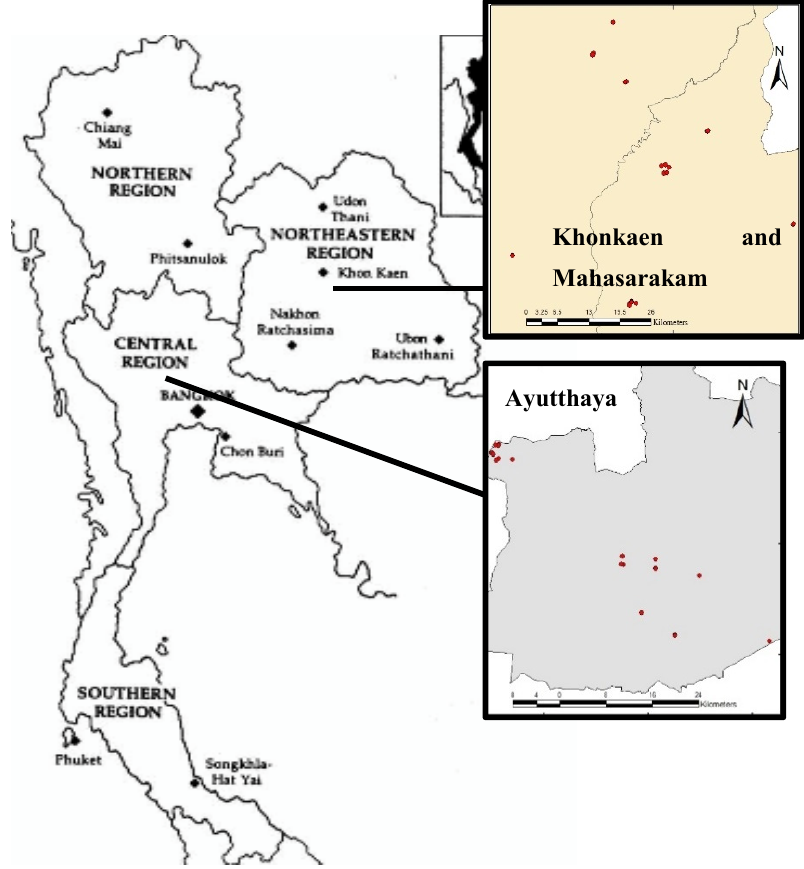
Figure 1. Study sites—Khonkaen, Mahasarakam, and Ayutthaya, Thailand.